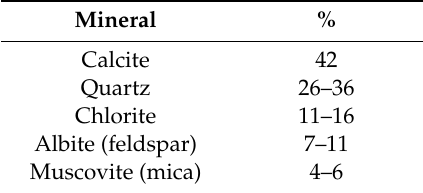
Table 3. Summary of mineralogical content.